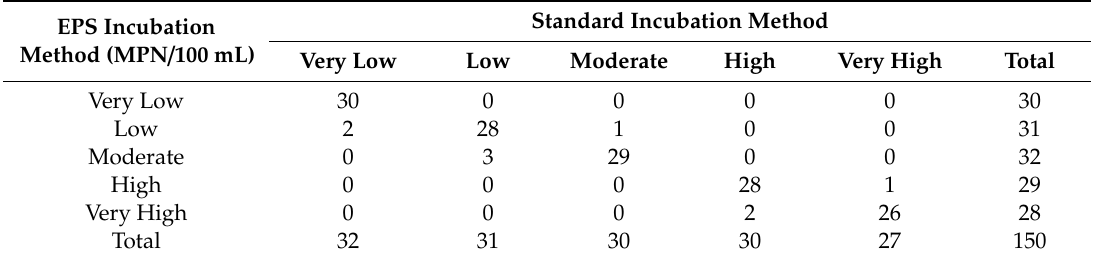
Table 3. Comparison of categorical risk assessments arising from the EPS and standard